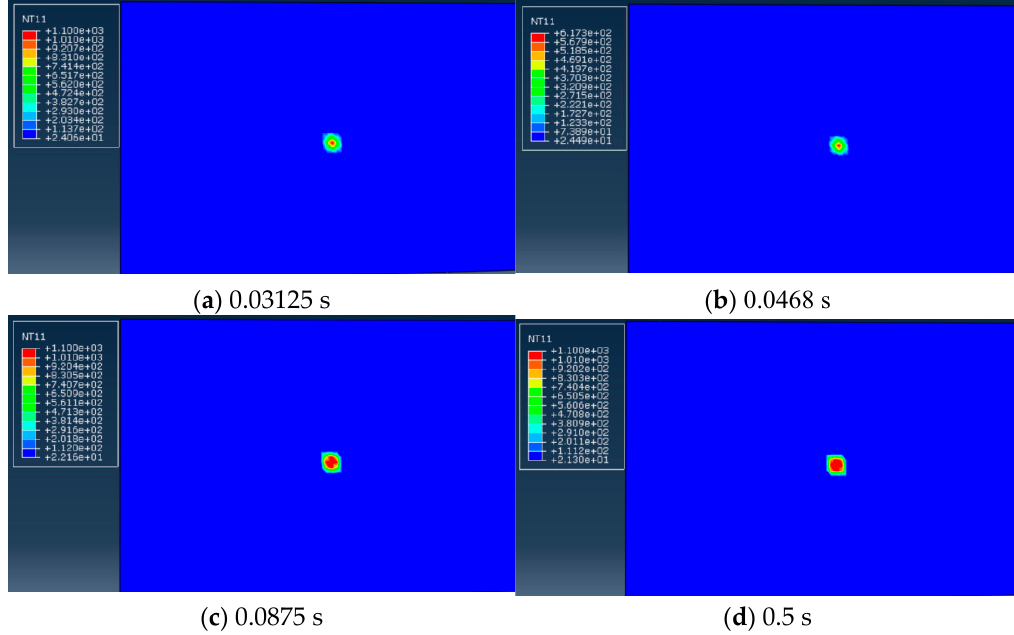
Figure 24. The temperature distribution cloud map of at the front face of the GFRC laminate under the component C with an amplitude of 800 A, ( a ) at 0.03125 s, ( b ) at 0.0468 s, ( c ) at 0.0875 s, ( d ) at 0.5 s.